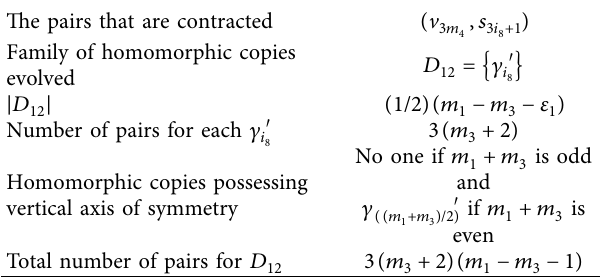
Table 11: Necessary information regarding homomorphic copies c 􏽮 􏽯 i 8 ′